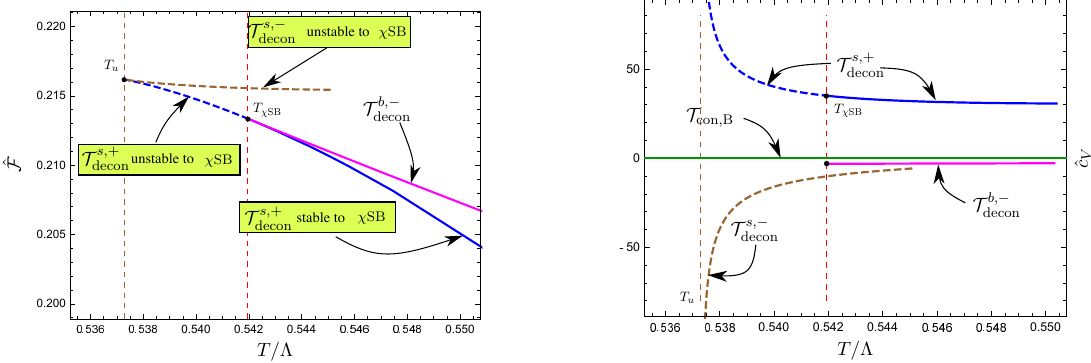
Figure 18 . Left panel: detailed phase diagram in the canonical ensemble at µ/ Λ = 0 for T & T u . s states unstable to spontaneous chiral symmetry breaking are denoted with dashed curves. decon T Right panel: specific heat ˆ c V (6.6) of different states. Brown curves denote ˆ c V < 0, and blue curves denote states (magenta curves), i.e., the Klebanov-Strassler black branes, is